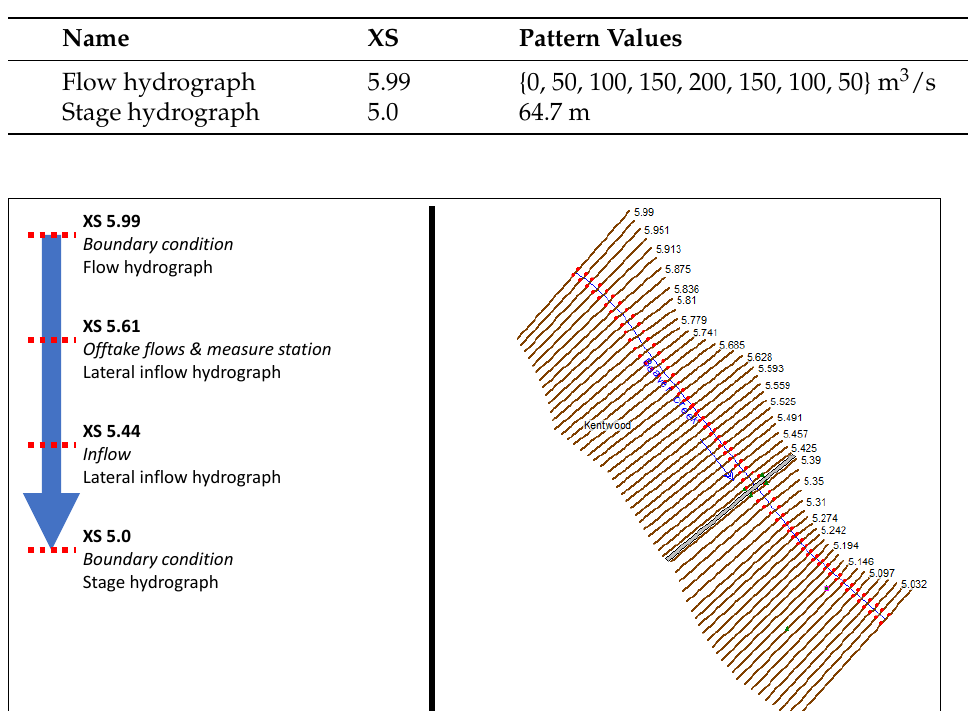
Table 4. Boundary conditions for the Beaver Creek case study.